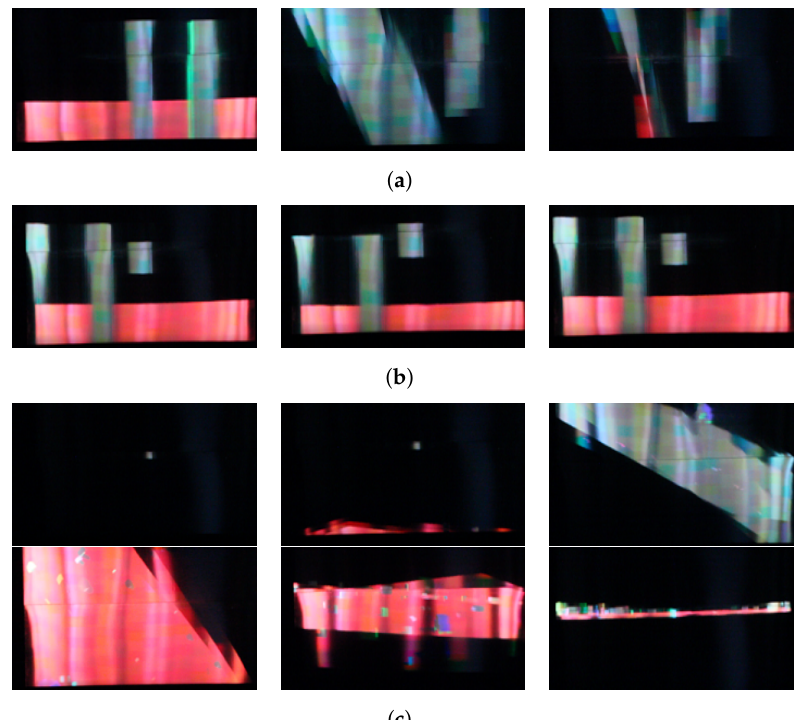
Figure 6. Physical simulation of cameras on the light field display [68]. ( a ) Collision camera. ( b ) Sus- pension camera. ( c ) Falling